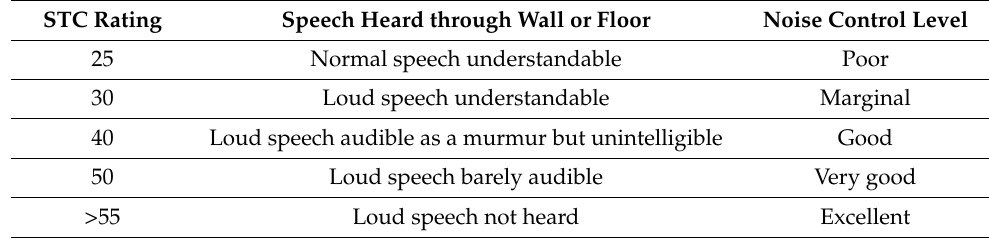
Table 3. STC ratings and noise